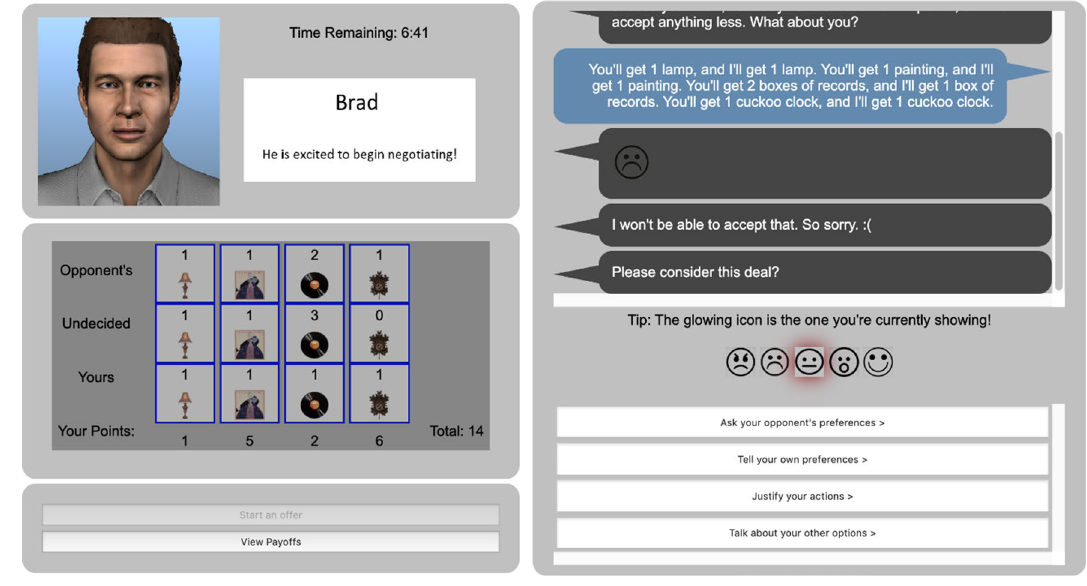
Figure 1. The interactive arbitration guide